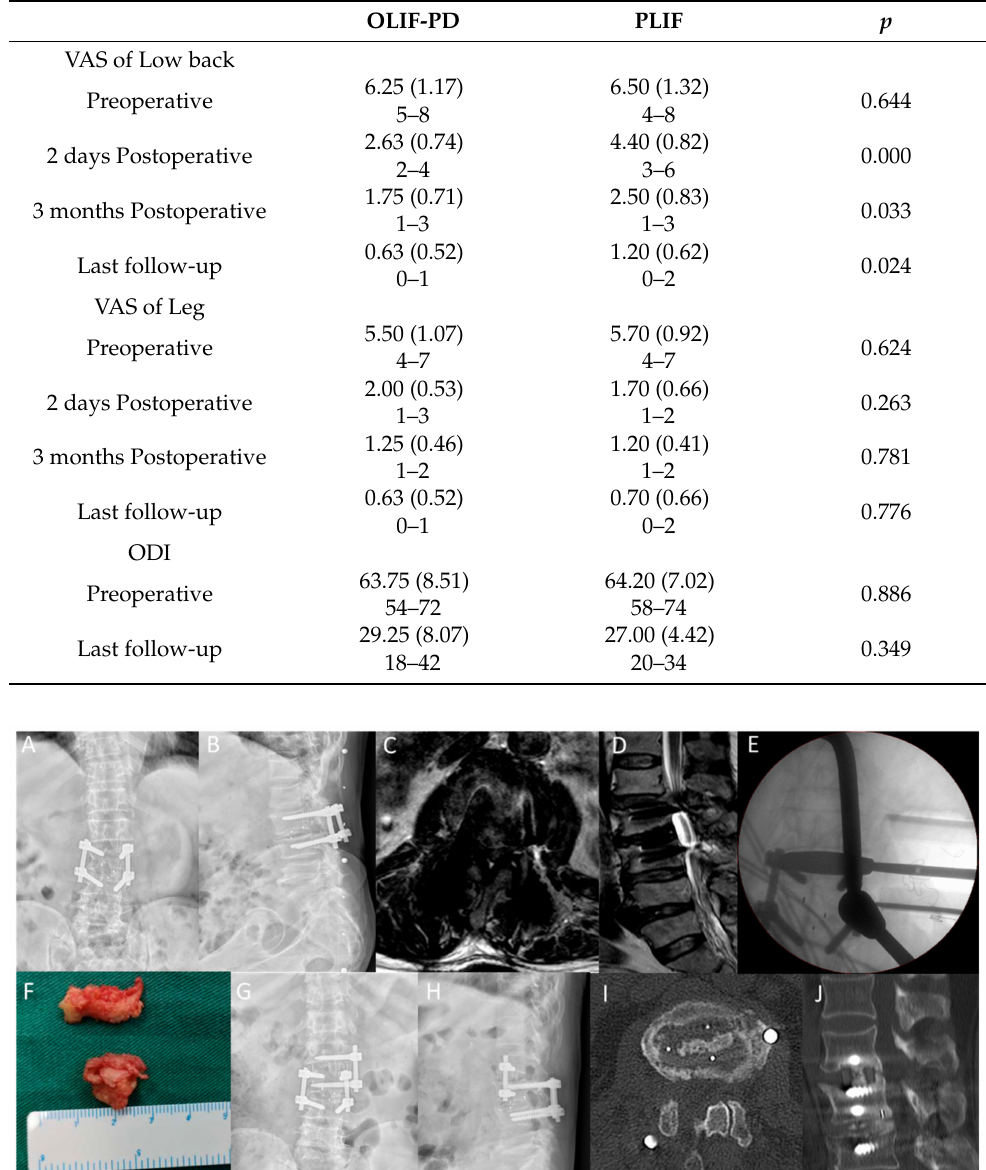
Table 3. Comparison of VAS and ODI data between the two groups.